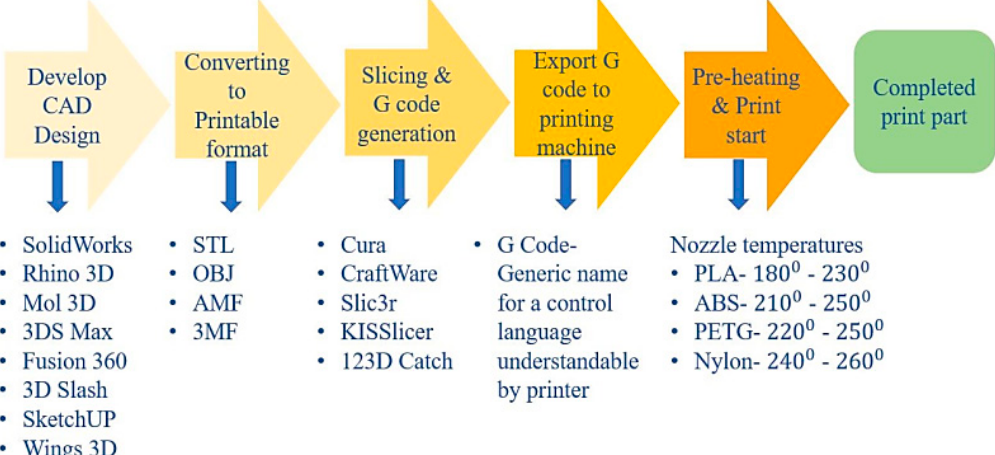
Figure 13. Simplified flowchart of FDM process flowchart, representing different types of software employed in the process and suggested nozzle temperature for some materials [96].